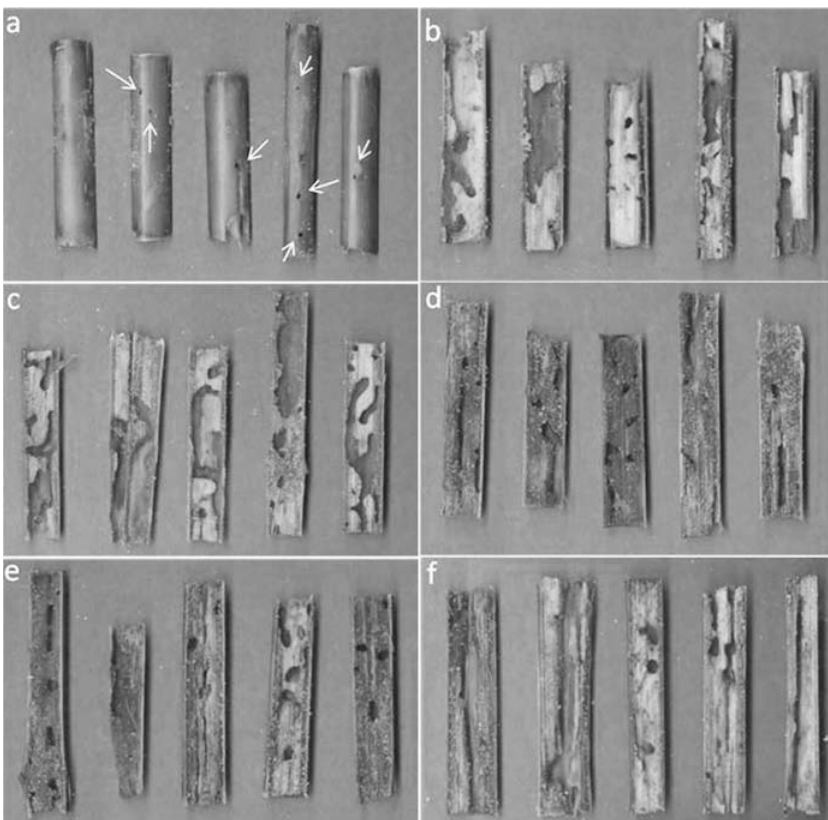
Fig. 3.(a) Holes made by C, formosanus pn the srface of split stalks at day 2-3 and the consumption pattern of termites feeding of (b) n-Bt-1, (c) nBt-2, (d) BtYG, (e) BtVT, (e) BtVTPROaand (f) BtSMT maize